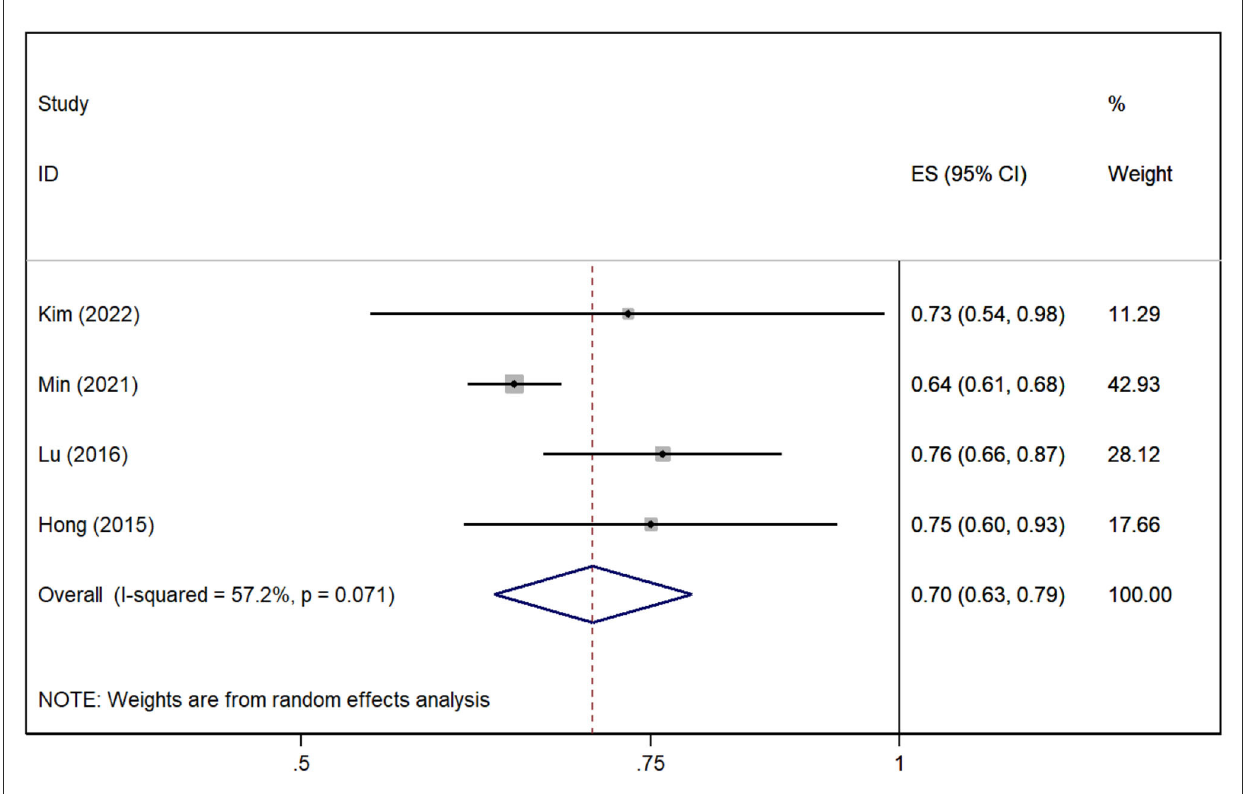
FIGURE3 Forest plot for the risk of AD in gout patients. ES, effect